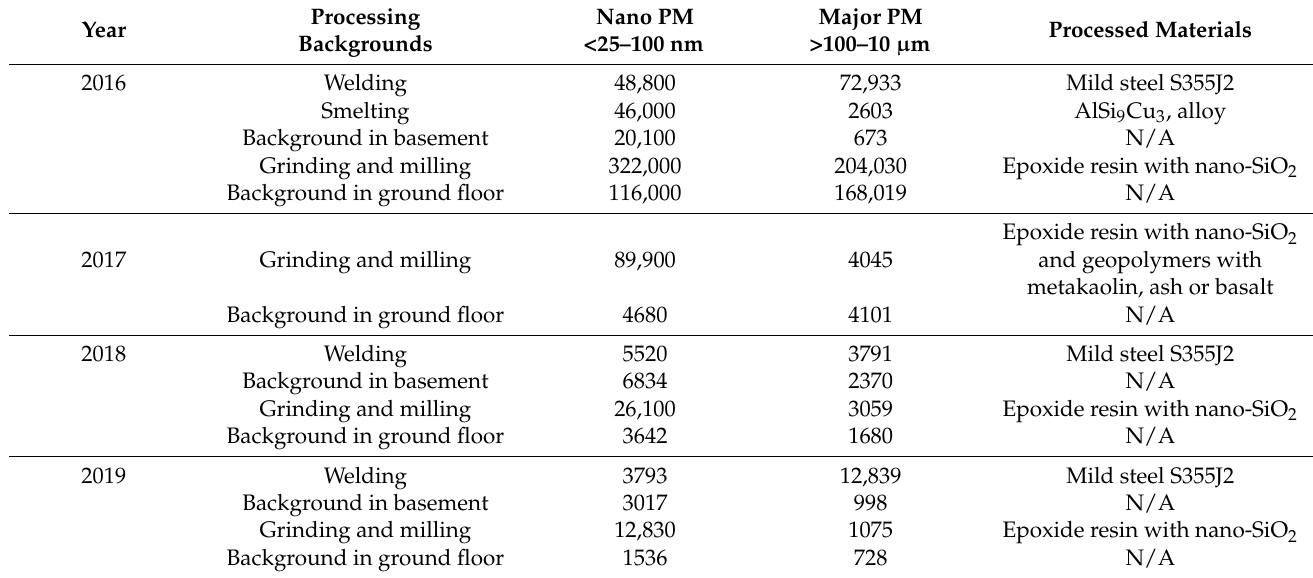
Table 2. Annual monitoring of total number concentration of nano PM fraction and PM > 100 nm per cm 3 related to individual working processes and background in working places of nanocomposite